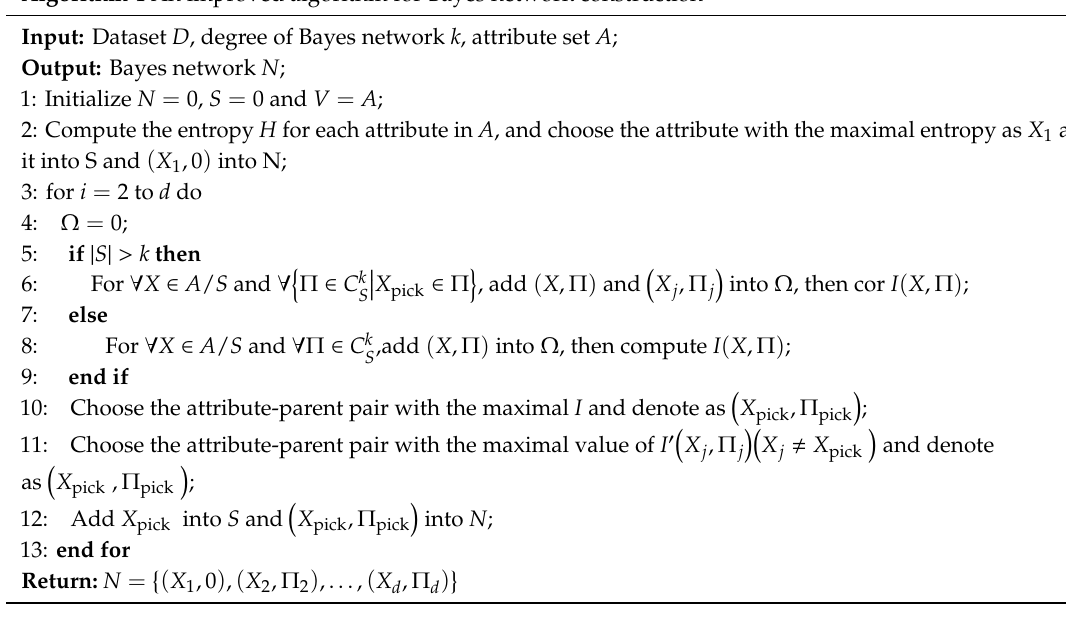
Algorithm 4 An improved algorithm for Bayes network